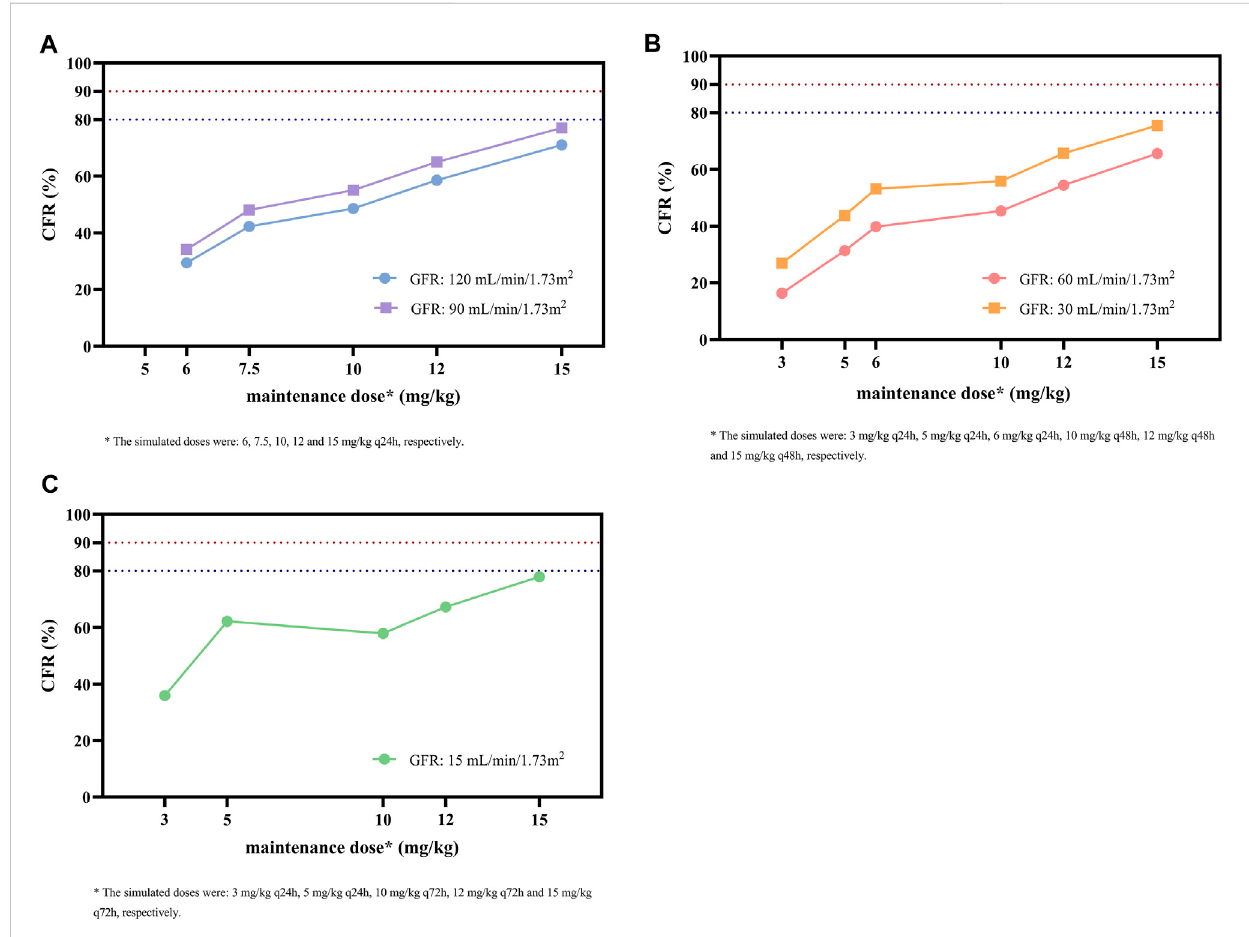
FIGURE 5 CFRofdifferentmaintenancedosesagainstMRSAforthetargetofAUC 0-24 /MIC ≥ 610insubgroupsstrati fi edbyGFR. (A) SubgroupswithGFRof120 and 90 mL/min/1.73 m 2 . (B) Subgroups with GFR of 60 and 30 mL/min/1.73m 2 . (C) Subgroup with GFR of 15 mL/min/1.73 m 2 . The MIC range and distribution are based on the EUCAST data published in 2022. The dashed blue and red lines indicate the target CFR of 80% and 90%,